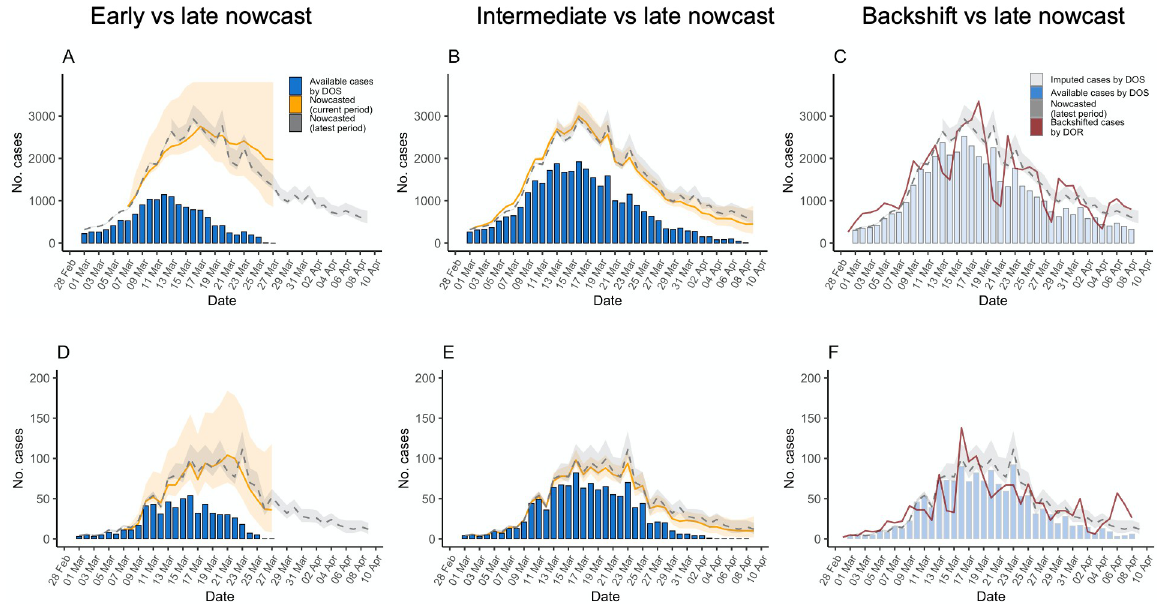
Fig 2. Epidemic curves estimated using the data available during the early and intermediate analysis of the initial SARS-CoV-2 outbreak in the regions of Madrid and Murcia, Spain, March 1-April 9, 2020, and comparison with curves obtained in late period of analysis March 1-April 16 (dashed grey line and grey ribbon). Showing nowcast estimates (orange) in Madrid and Murcia for the early (A and D) and intermediate (B and E) period analysis, observed cases with known date of onset of symptoms for the same period (blue columns), and for comparison with more complete data, those estimated in the late period of analysis (dashed grey line and ribbon); C and F showing cases by date of report back shifted by the mean delay (red line) together with nowcast estimates for the late period analysis and observed cases with known date of onset of symptoms (shadowed blue columns). DOS: date of onset of symptoms; DOR: date of report; Lines are median estimates, ribbons span 2.5 and 97.5 percentiles.